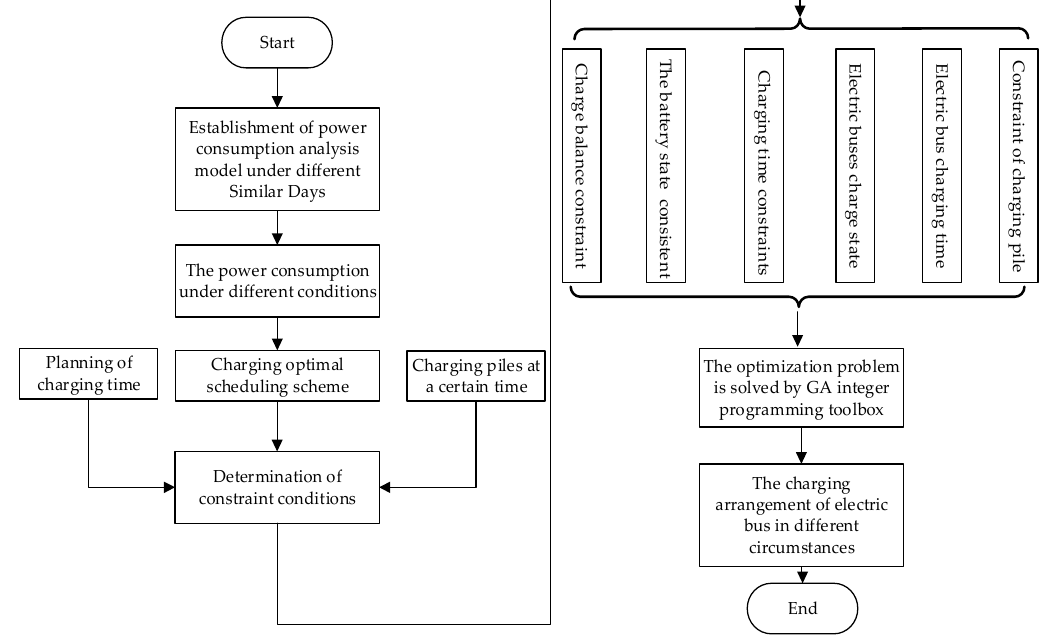
Figure 5. Frame flow chart of power consumption analysis and electric buses charging optimization.